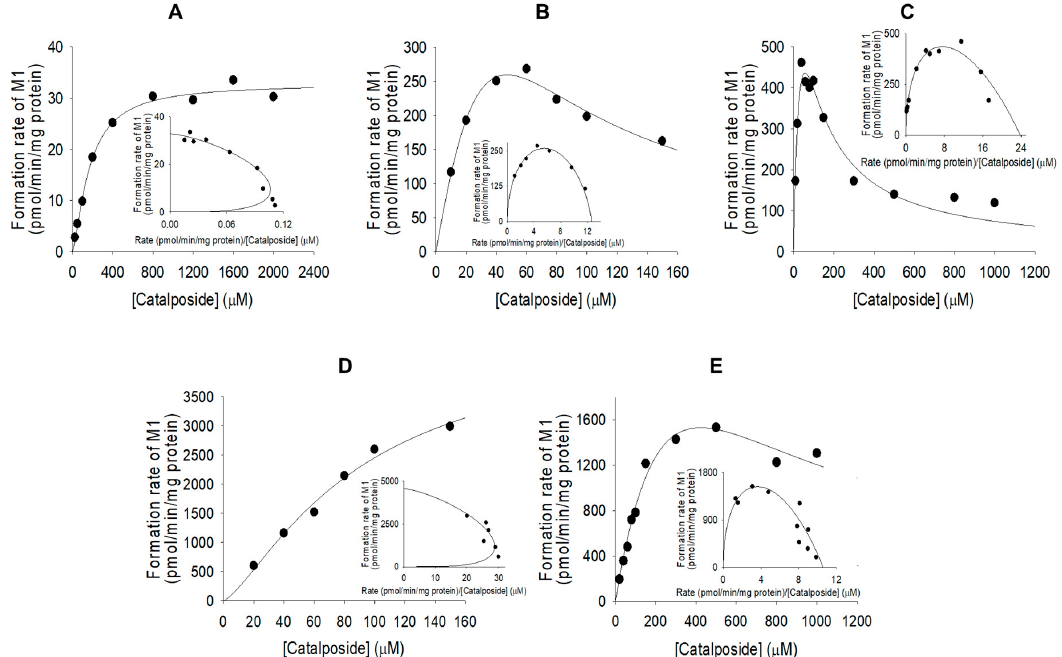
Figure 4. Rate of formation of catalposide sulfate (M1) from 150 μ M catalposide by human cDNA-